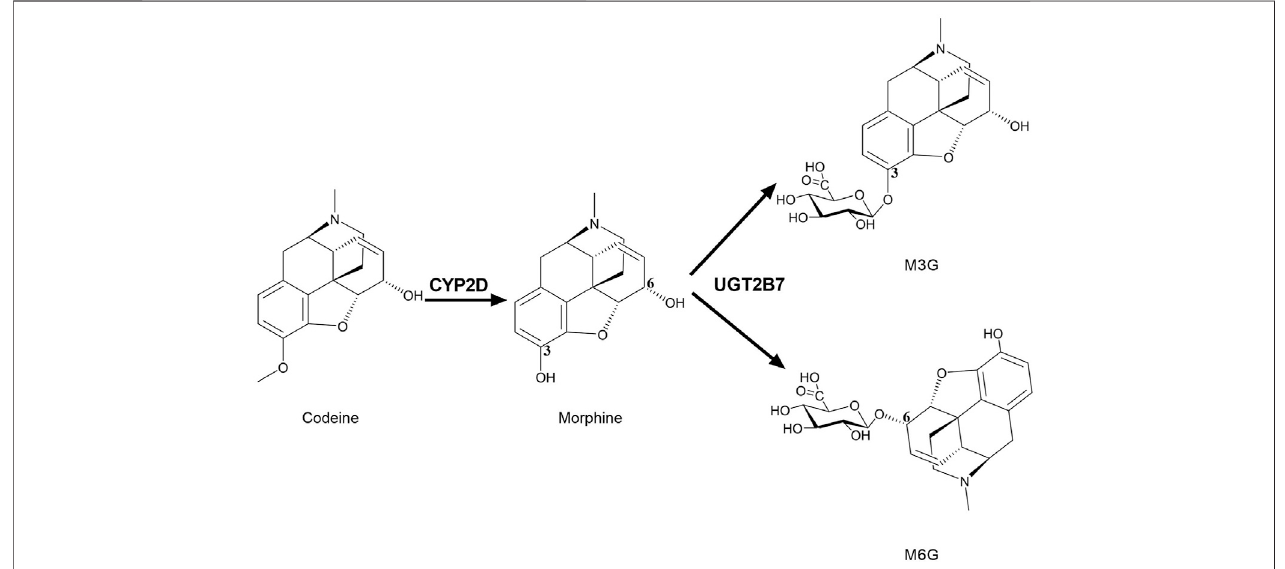
FIGURE2| BrainCYP2DandUGT2B7mediatethemetabolismofcodeineandmorphine.CYP2Dcatalyzesthedemethylationofcodeineintomorphine.UGT2B7 mediates the glucuronidation of positions 3 and 6 of the hydroxyl groups of morphine into M3G and M6G. CYP2D, Cytochrome P450 2D; UGT2B7, UDP- glucuronosyltransferase 2B7; M3G, morphine-3-glucuronide; M6G, morphine-6-glucuronide.